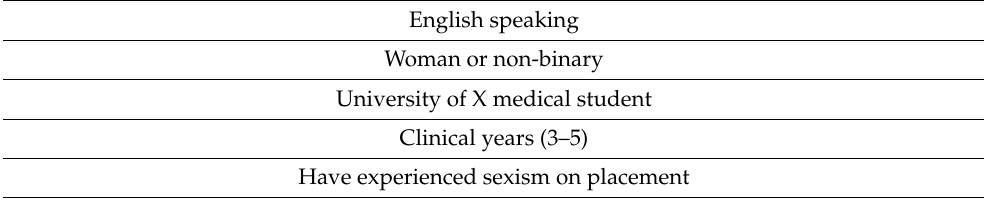
Table 1. Participant Inclusion